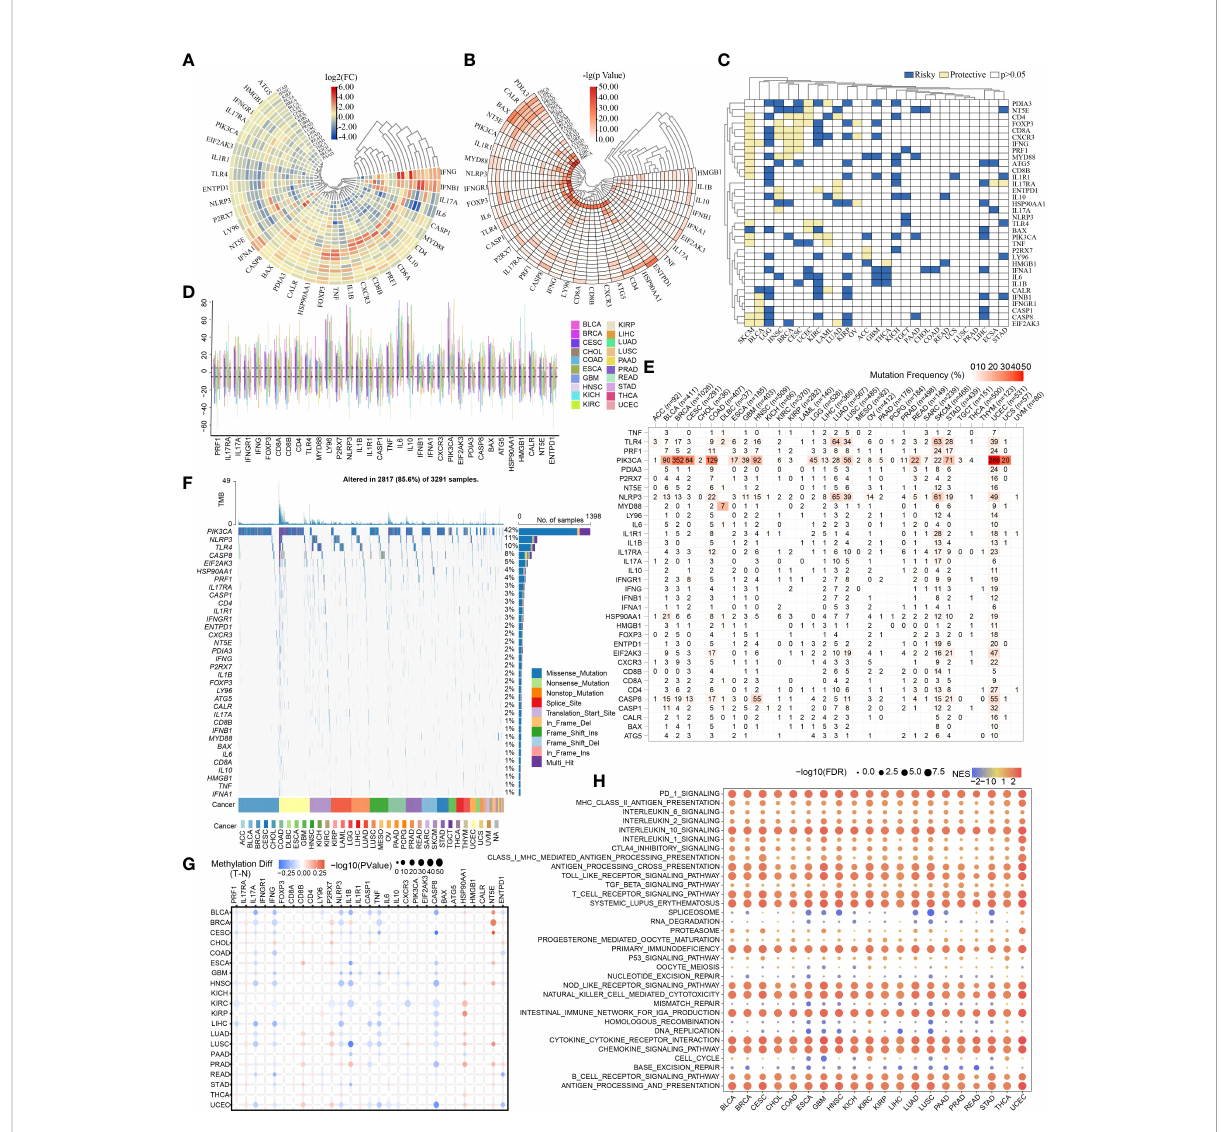
FIGURE 2 Pan-cancer overview of ICD-related genes. The discrepancies in expression levels of ICD-related genes across pan-cancer and corresponding paracancerous tissues (A) : log2(FC), (B) : -lg(pValue)). (C) Survival landscape of ICD-related genes across cancer types. (D) CNV of ICD-related genes in various cancers. (E, F) SNV frequencies and types in pan-cancer. (G) Methylation variation of ICD-related genes in pan-cancer. (H) Immune-related pathways affected by ICD-related genes (The redder the color, the higher the normalized enrichment score (NES); the larger the dot, the lower the corrected